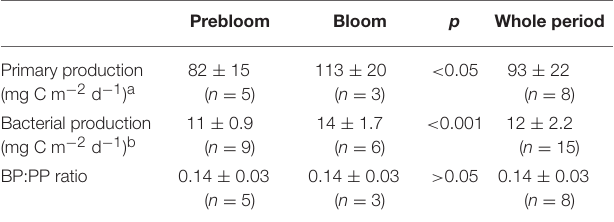
TABLE 3 | Comparison of depth-integrated (0–20m) primary (PP) and bacterial production (BP) during prebloom and bloom